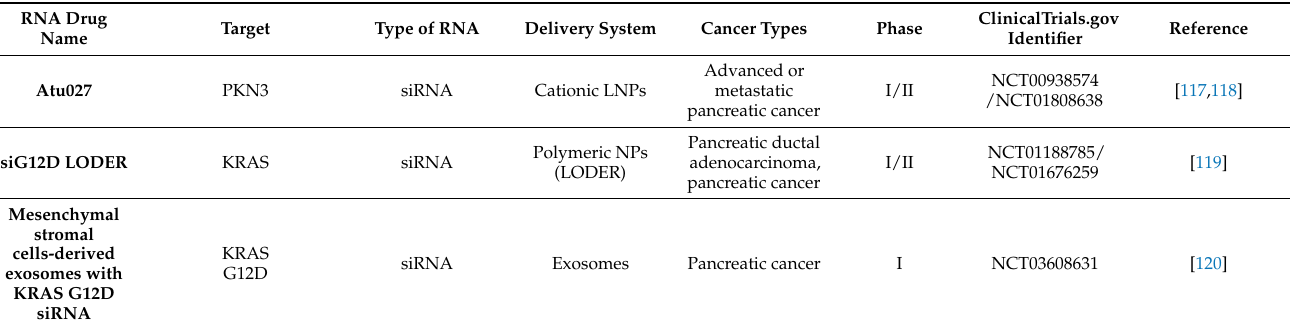
Table 1. RNA drugs in clinical